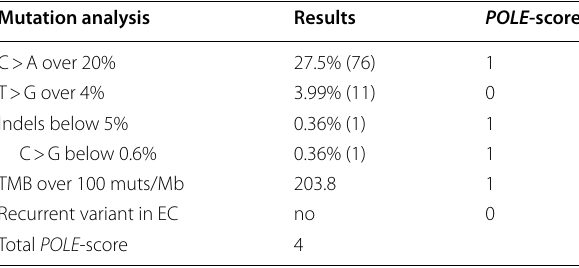
Table 2 Pathogenicity evaluation based on the POLE -score system Mutation